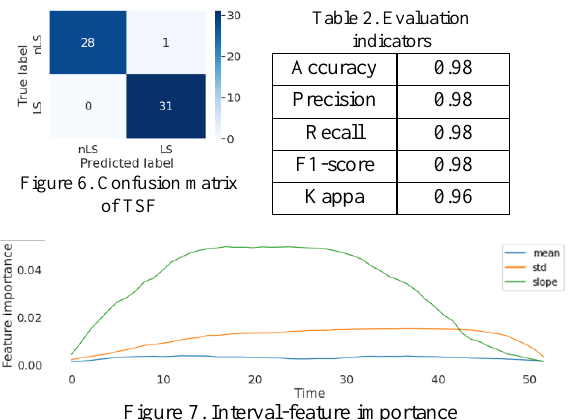
Figure 7. Interval-feature importance